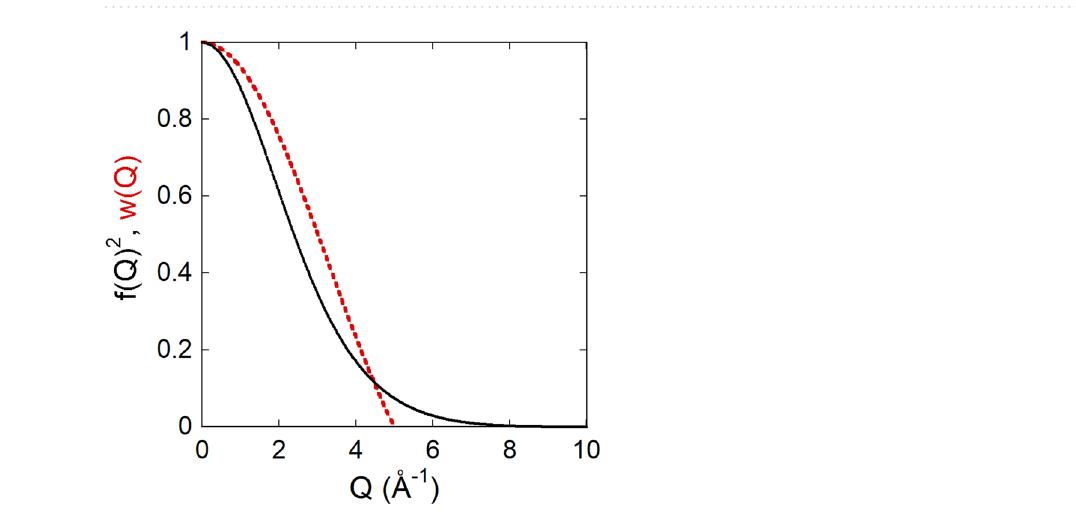
Figure 2. Squared magnetic form factor of Fe 2+ as a function of Q (solid black line) and window function of Eq. (5) with Q max = 5 Å −1 (broken red